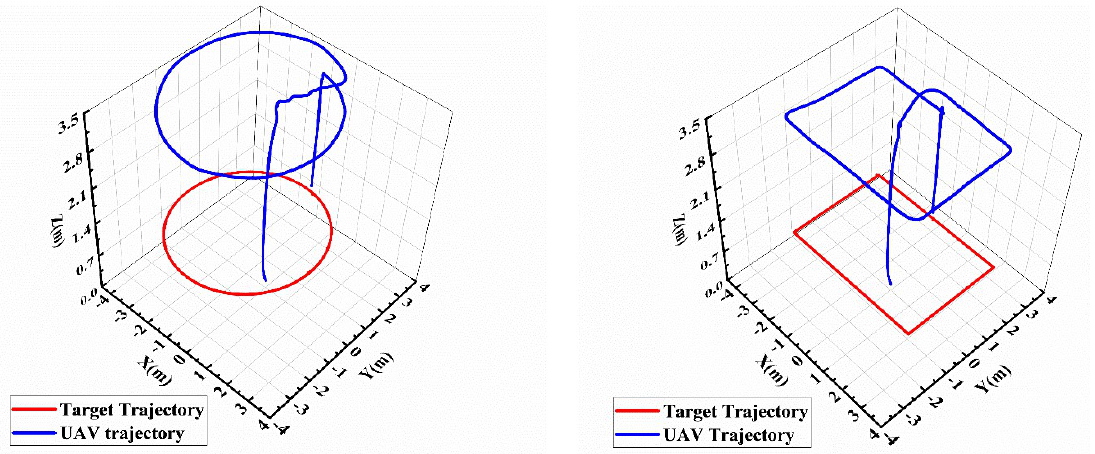
Figure 14. Drones tracking targets with different trajectories.